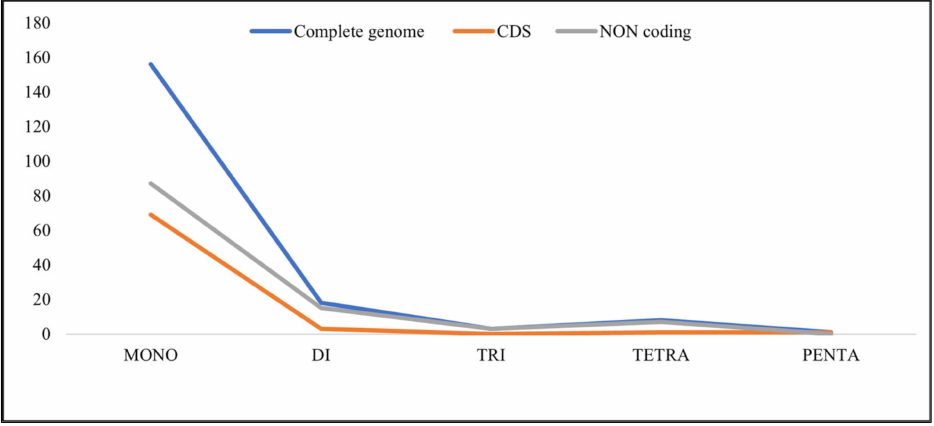
Figure 10. Number of different SSR types in Ficus populifolia plastome.